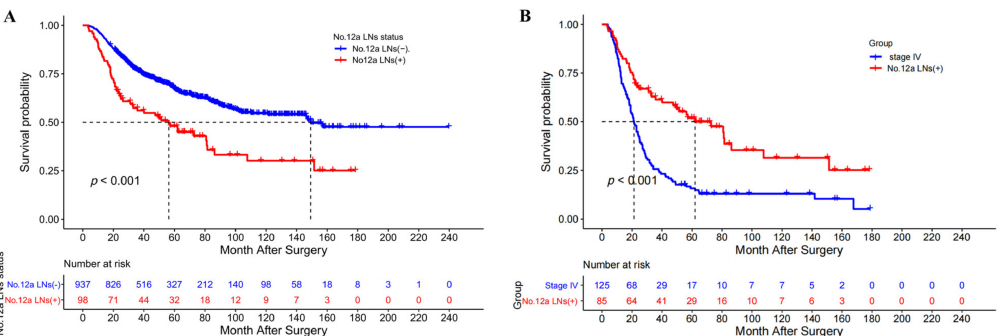
Figure 1. ( A ) The overall survival curves of patients with and without No. 12a LN metastasis after a D2 gastrectomy; ( B ) The overall survival curves of patients with No. 12a LN metastasis (stage IV not included) and patients with stage IV after D2 gastrectomy. Table 3. Logistic regression analysis of independent risk factors for No. 12a LN metastasis. Univariate Analysis Multivariate No. 12a LN Metastasis Case, n Factors (%)